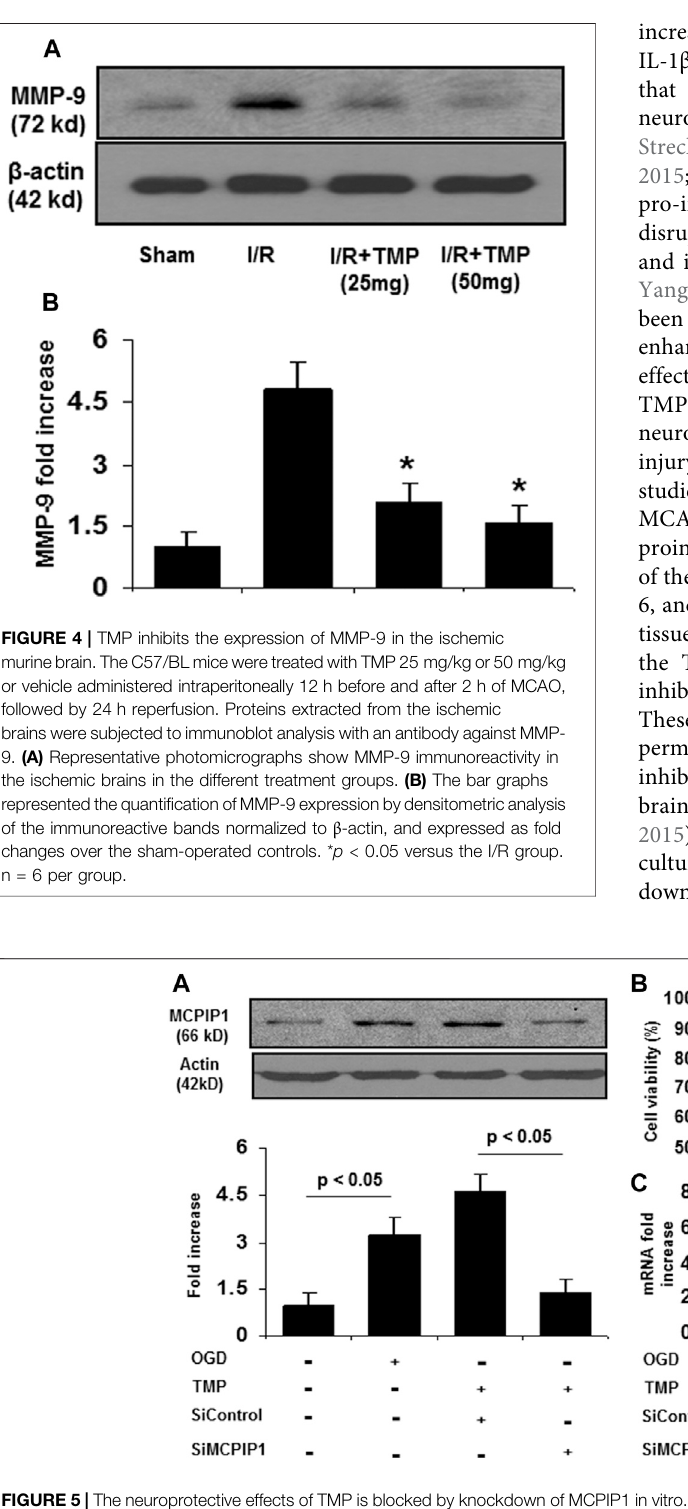
Frontiers in Pharmacology |